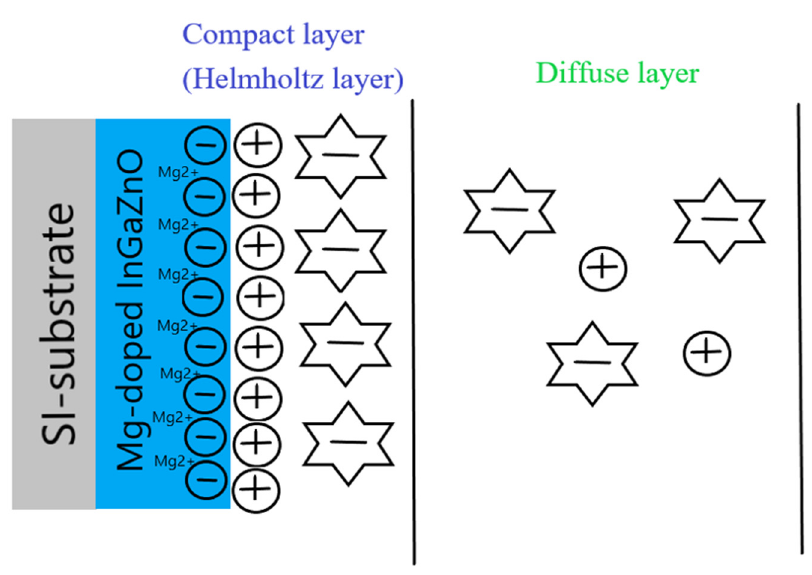
Figure 8. The C DL decrease caused by Mg doping in the site-binding model.